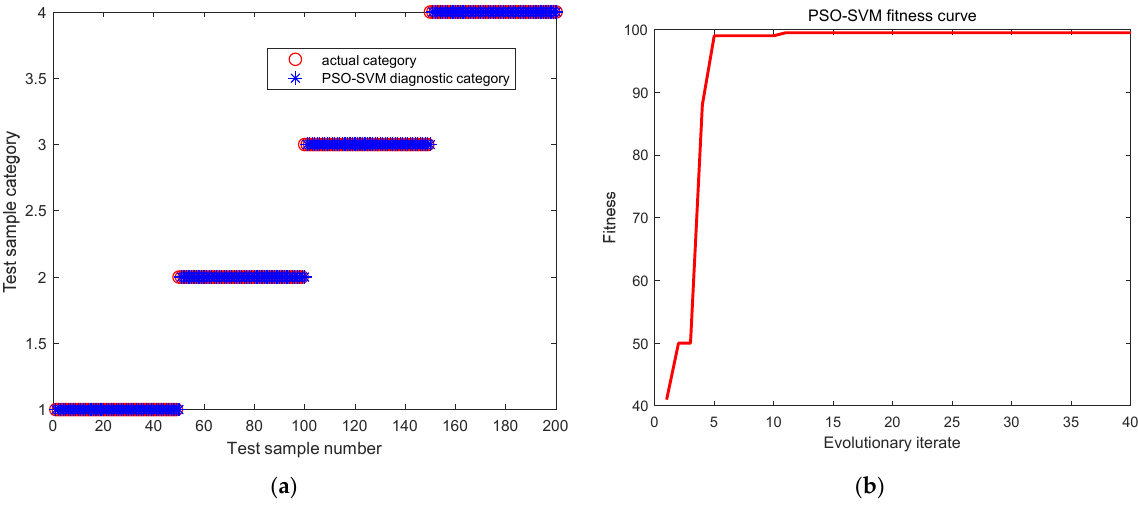
Figure 9. The test results based on PSO-SVM model. ( a ) The classification results ( b ) The fitness change curve.